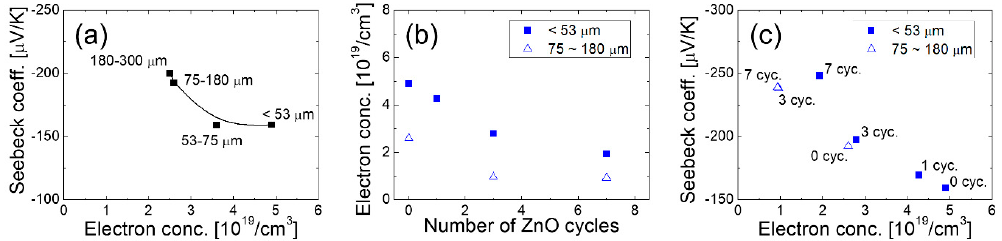
Figure 5. ( a ) Pisarenko plot of uncoated Bi 2 Te 2.7 Se 0.3 with di ff erent powder sizes; ( b ) Variation in the electron concentration of ZnO-coated Bi 2 Te 2.7 Se 0.3 with di ff erent powder sizes, as a function of the number of ZnO ALD cycles; ( c ) Pisarenko plot of ZnO-coated Bi 2 Te 2.7 Se 0.3 with di ff erent powder